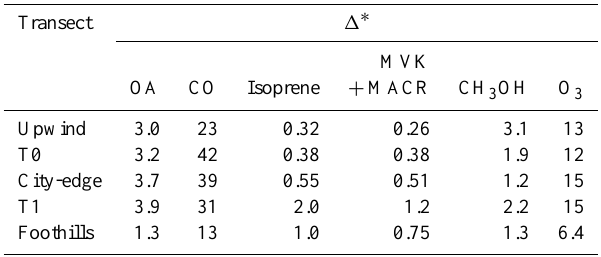
Table 4. Plume perturbations, (cid:49) s, averaged over transects at five locations.